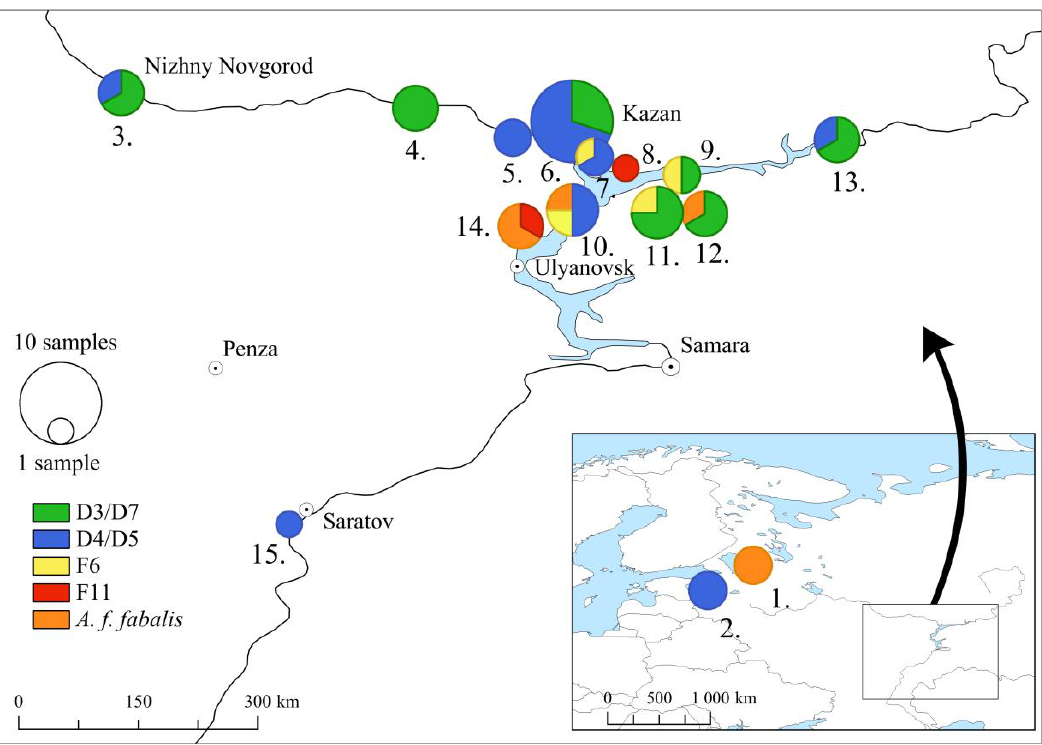
Figure 5. Haplotype frequencies in ancient goose samples from archaeological sites based on the concatenated hypervariable part of the mitochondrial control region (204 bp). The sampling locations are as follows: 1. Staraya Ladoga (Leningrad Region), 2. Pskov city (Pskov Region), 3. Nizhny